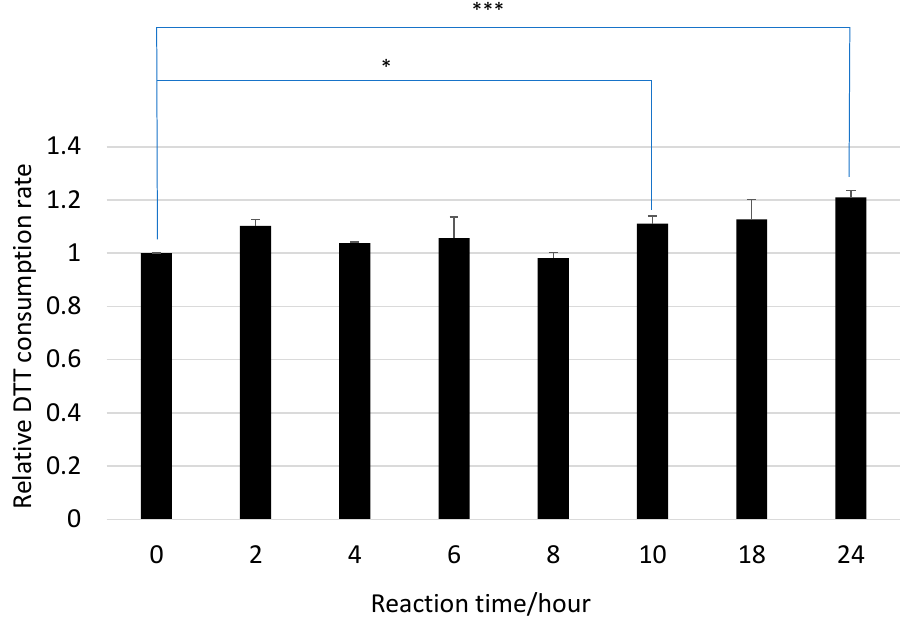
Figure 1. Dithiothreitol (DTT)-consumption rates of HA before and after ozone exposure (mean ± SD; N = 6; * p < 0.05, *** p <